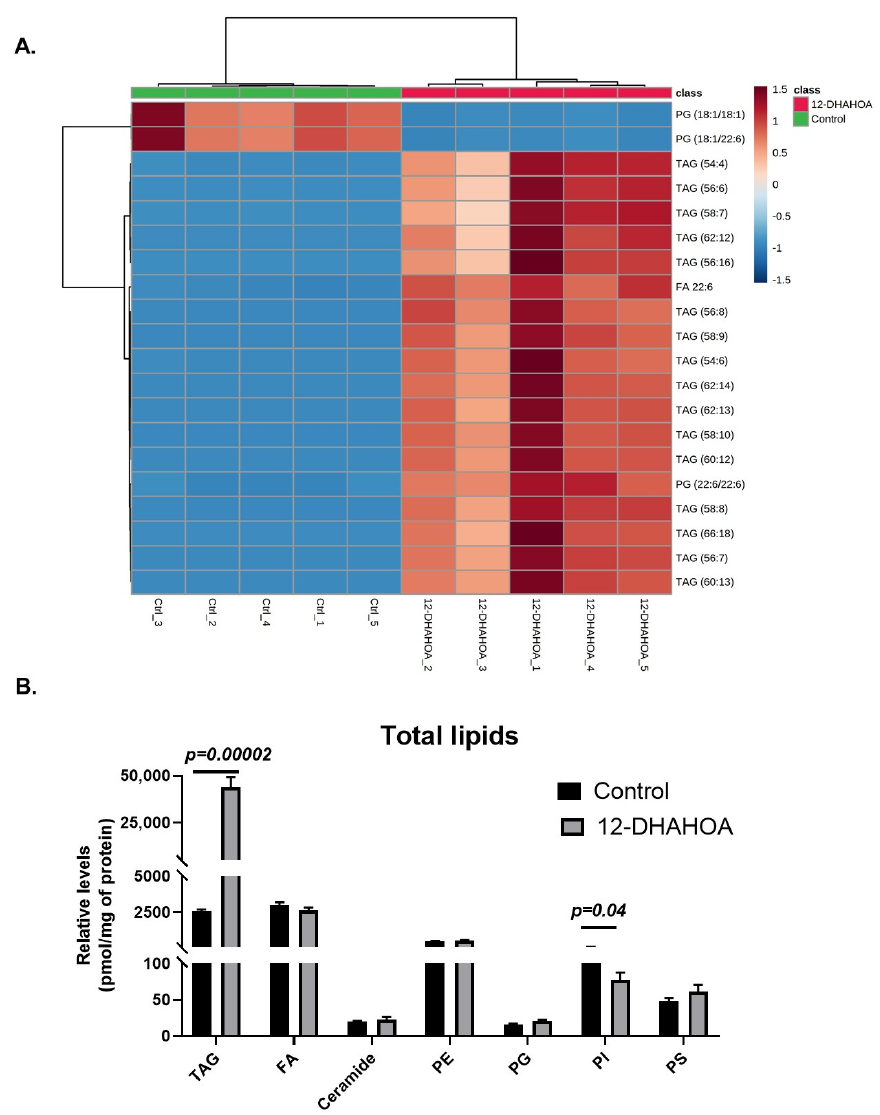
Figure 5. ( A ) Hierarchical cluster correlation analysis of top 20 significantly altered species ( t -test, p < 0.05, distance measure: Euclidean; clustering algorithm: Ward. Each colored cell on the map corresponds to a concentration value of lipids, with samples in rows and compounds in columns. Red: increased, Blue: decreased). ( B ) Relative levels of total lipids in control (C3A) and 12-DHAHSA treated samples ( t -test, p < 0.05) (mean ± SEM ( n = 5). (TAG: Triacylglycerol, FA: Fatty acid, PE: Phosphatidylethanolamine, PG: Phosphatidylglycerol, PI: Phosphatidylinositol, and PS: Phosphati- dylserine).